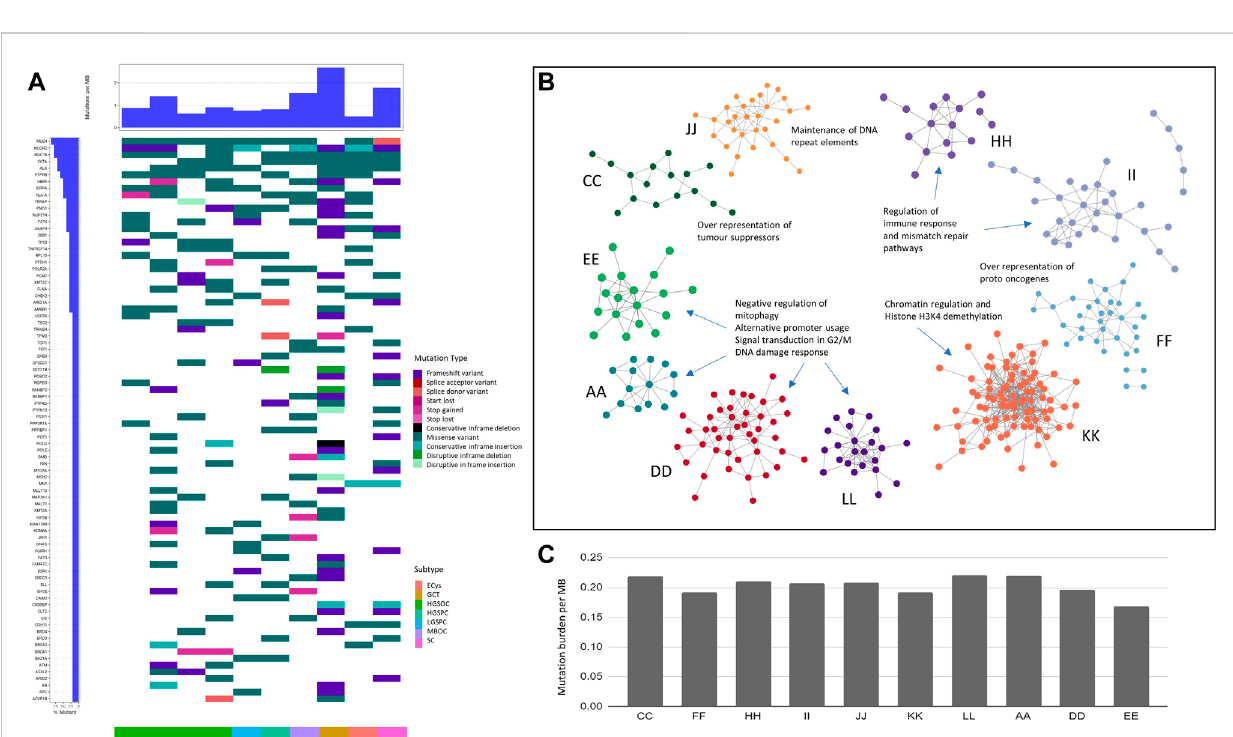
FIGURE 1 Exome analysis of ovarian cancer histotypes in the Indian cohort. (A) . Waterfall plot showing mutations in COSMIC driver genes across ovarian cancer subtypes. (B) . Pathways affected by mutations across subtypes. (C) . Ovarian cancer samples tumour mutation burden per MB in